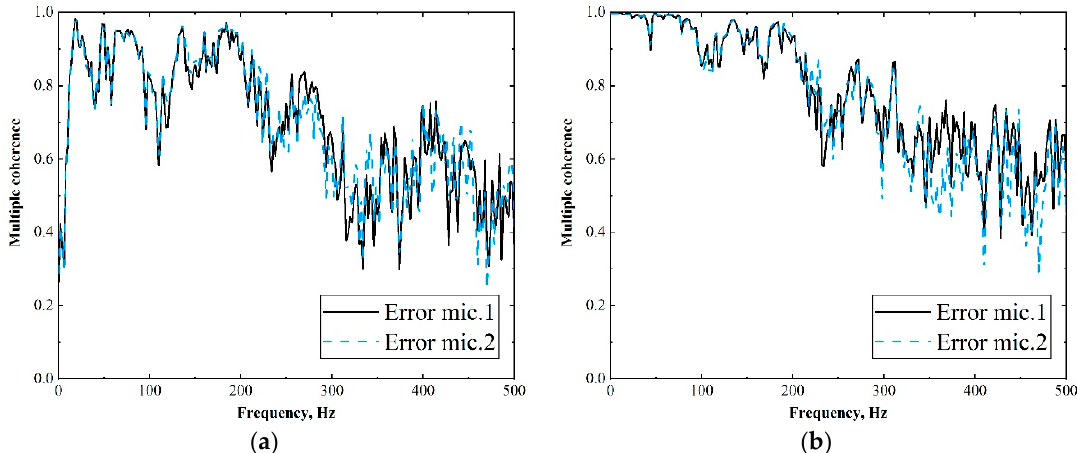
Figure 5. The multiple coherence between each of the error microphones and all selected vibrational or acoustical reference signals when the SUV was driven at a constant speed of 80 km/h on a rough road. ( a ) Ten vibrational reference signals; ( b ) Ten acoustical reference signals.